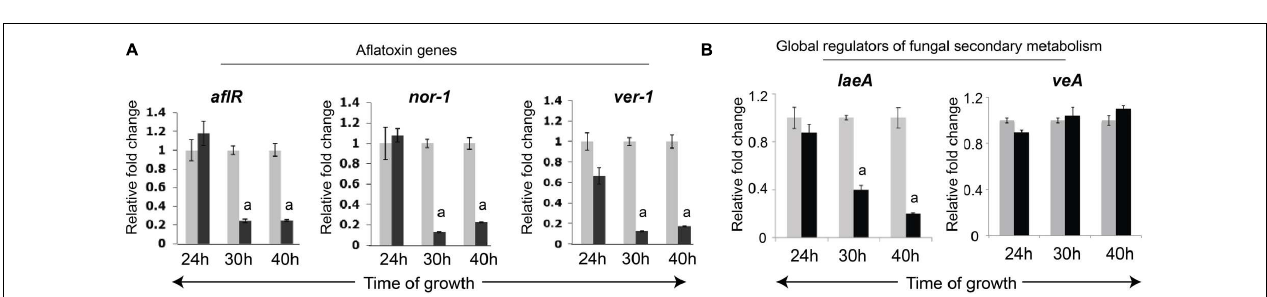
FIGURE 5 | Comparison of HPLC traces of ARMs extract and the prodigiosin fraction of V. gazogenes.